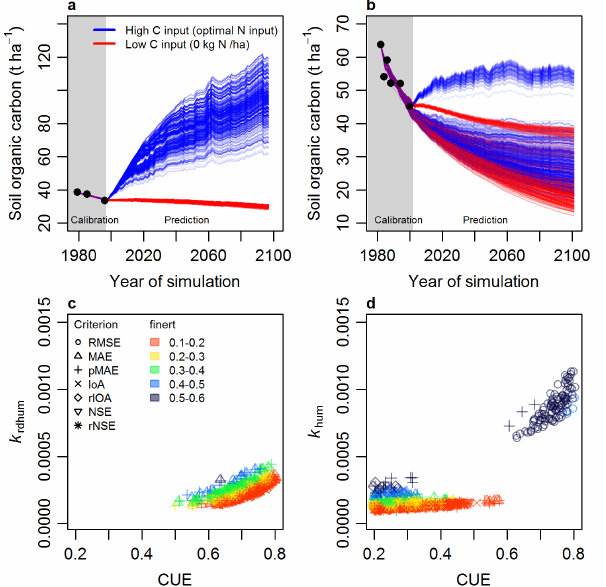
Figure 2. Projected soil organic carbon dynamics at two case sites Tarlee (a) and Brigalow (b) and the correspondingly used parameter ensembles ( c and d ). Black symbols show the observations. Seven criteria (RMSE, MAE, pMAE, IoA, rIoA, NSE and rNSE; see Ta- ble 3 in the Supplement for details) are used to derive the posterior joint distribution of model parameters (CUE, k hum and finert). CUE, microbial carbon use efficiency; k hum , the potential decomposition rate of humic organic carbon; finert, the fraction of inert organic carbon.